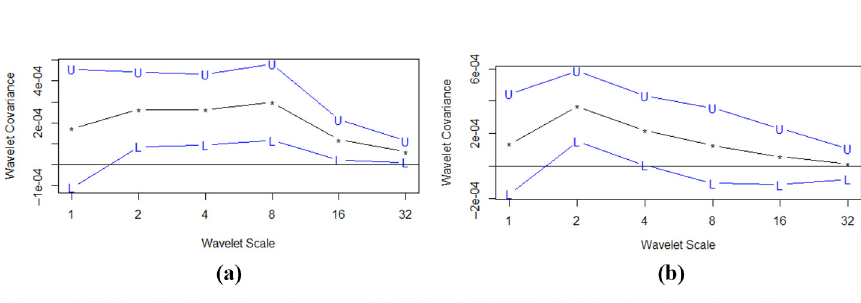
Table 2. Energy decomposition for WTI crude oil price and stock indices CNX Nifty and SCI